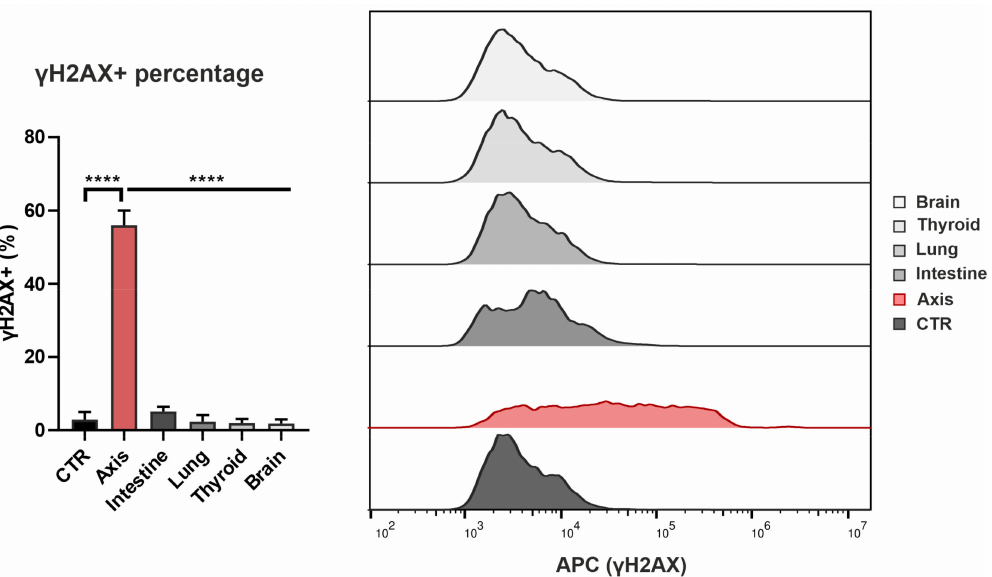
Figure 3. Effect of VMAT irradiation on the level of double-strand breaks in healthy human prostate cells positioned in the beam axis and peripheral organs. The level of DNA double-strand breaks was measured with flow cytometry using the γ H2AX marker. The percentage of γ H2AX-positive PNT1A cells was measured for irradiated cells in each peripheral organ location. Data are shown as means ± SD of three independent experiments. ****— p < 0.0001, based on one-way ANOVA with Tukey’s post-hoc test.